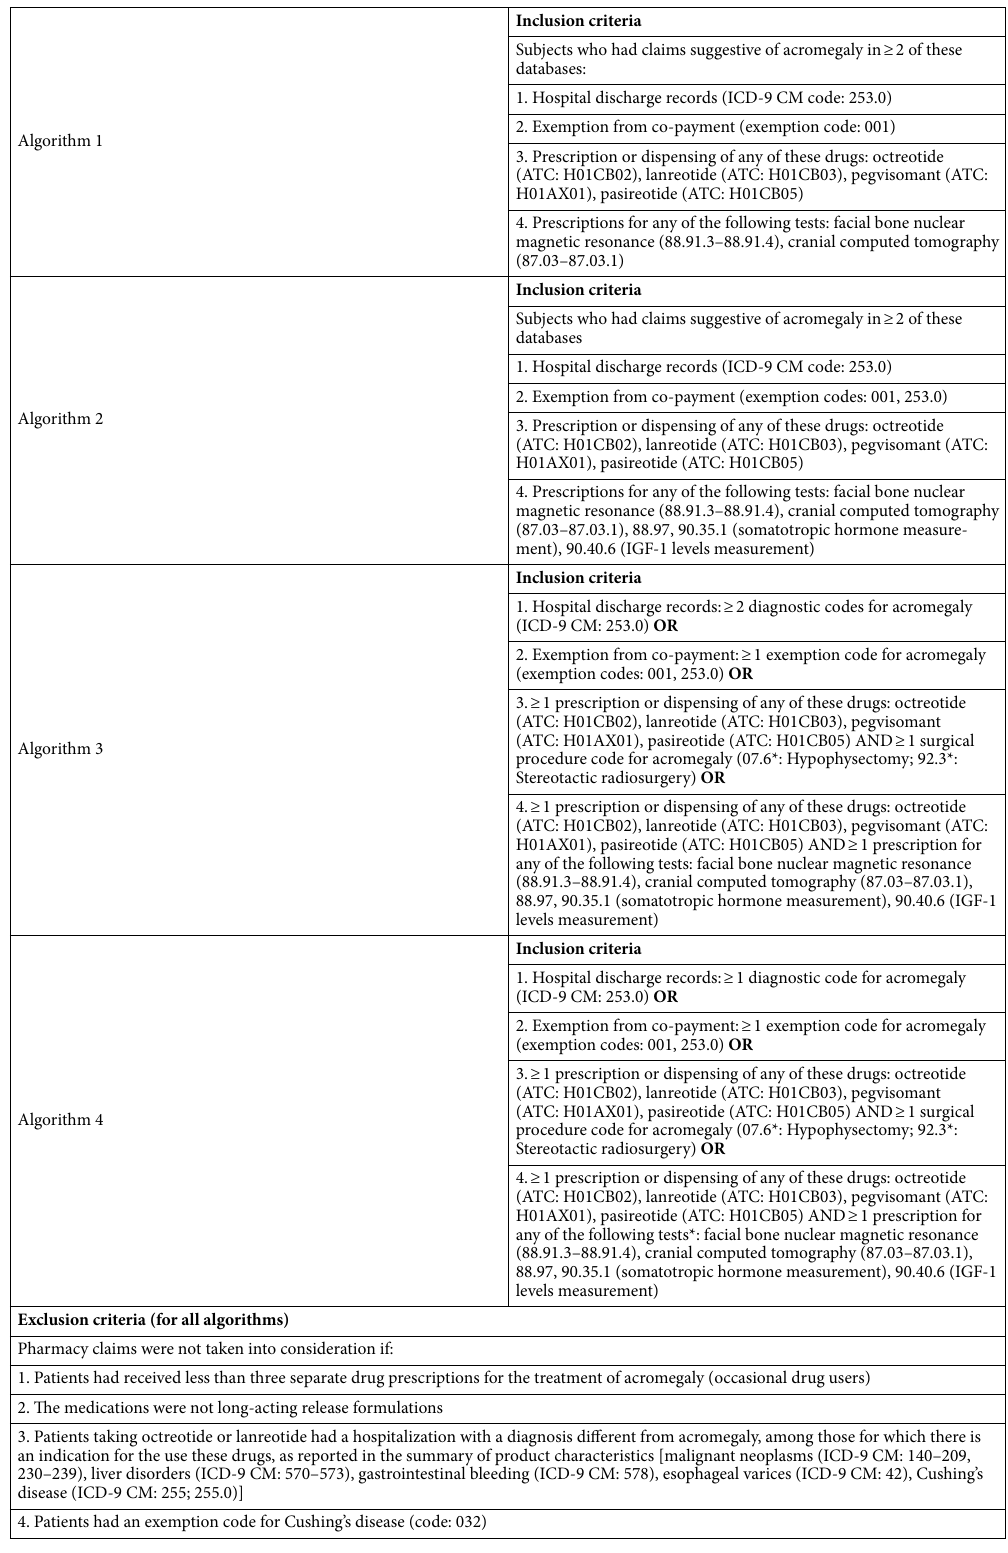
Table 1. Inclusion and exclusion criteria for each proposed algorithm for the identification of acromegaly cases. *Italian coding